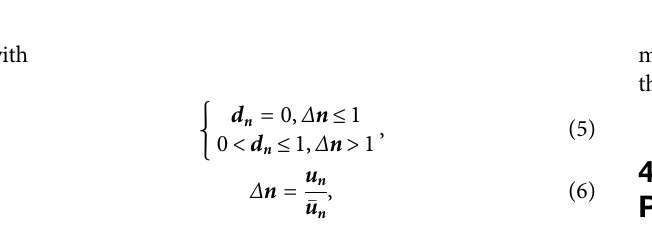
Frontiers in Earth Science |